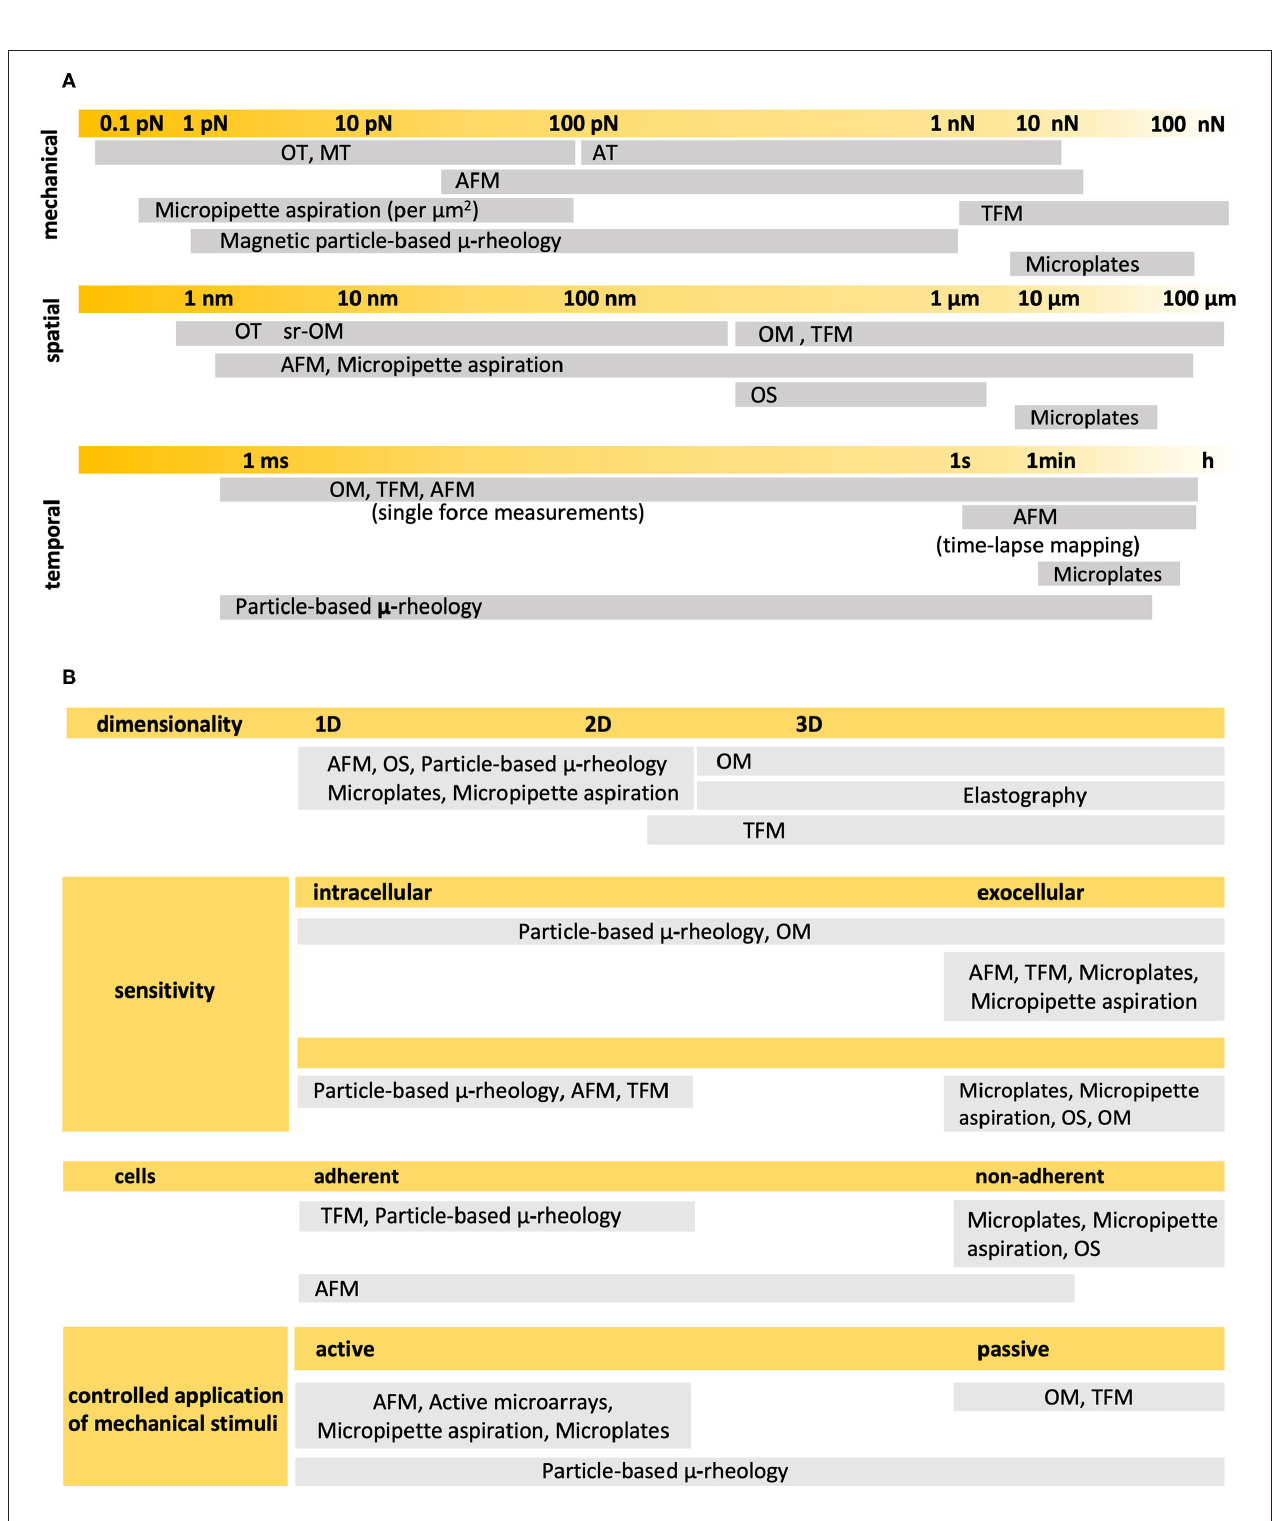
Frontiers in Mechanical Engineering |